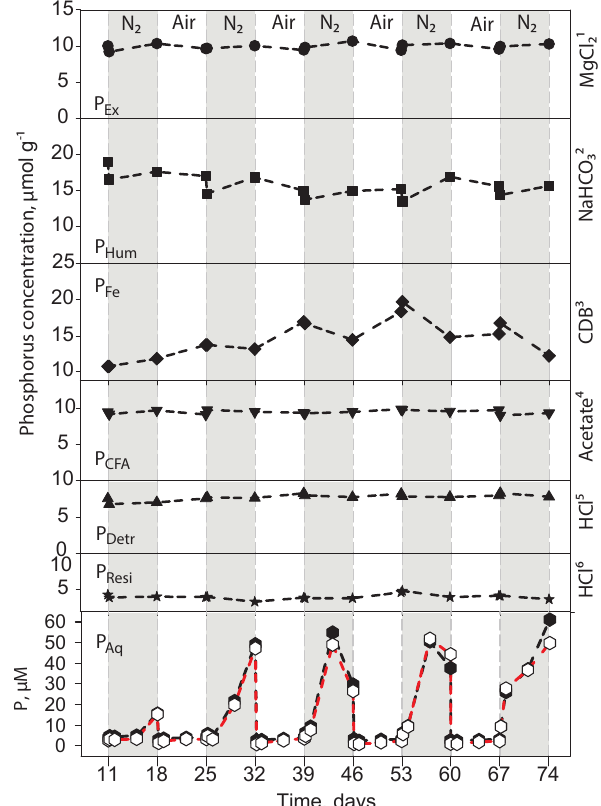
Figure 4. Aqueous- and solid-phase phosphorus speciation from se- quential chemical extractions with time during the reactor experi- ment. White panels correspond to time periods with air sparging, and grey panels correspond to time periods with N 2 :CO 2 sparg- ing. Black symbols are total P concentration, and white symbols are SRP